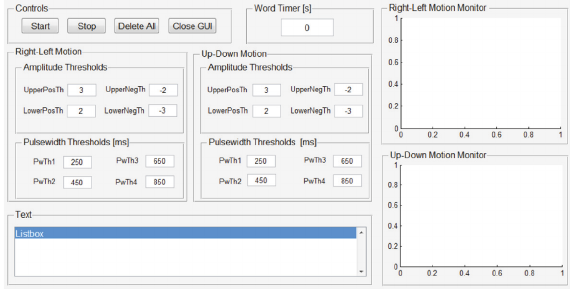
Figure 6: Graphic user interface of the developed system.